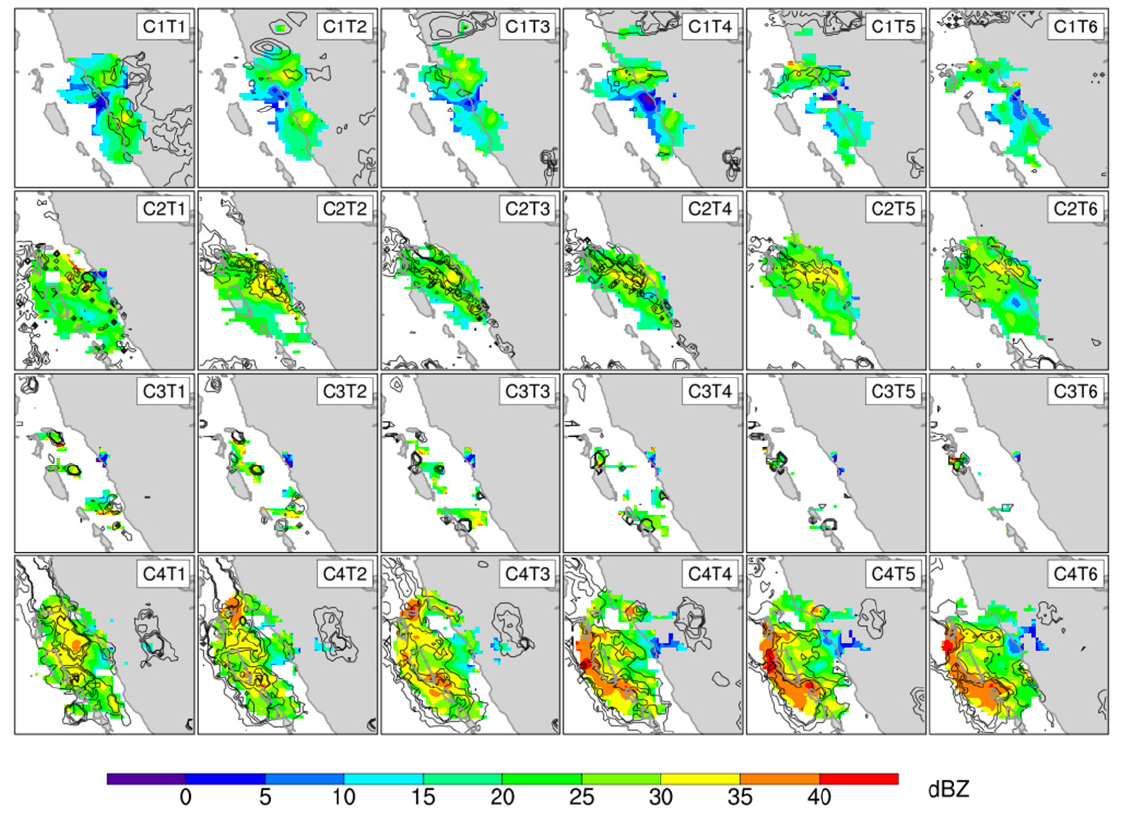
Figure 4. Padang radar reflectivity (shaded, dBZ) and IMERG precipitation rate (contours, >1 mm/h in Case 3 and >3 mm/h in other cases) during 01 h–06 h in Cases 1–4. The CxTy in the panels indicates the yth hour of Case x.